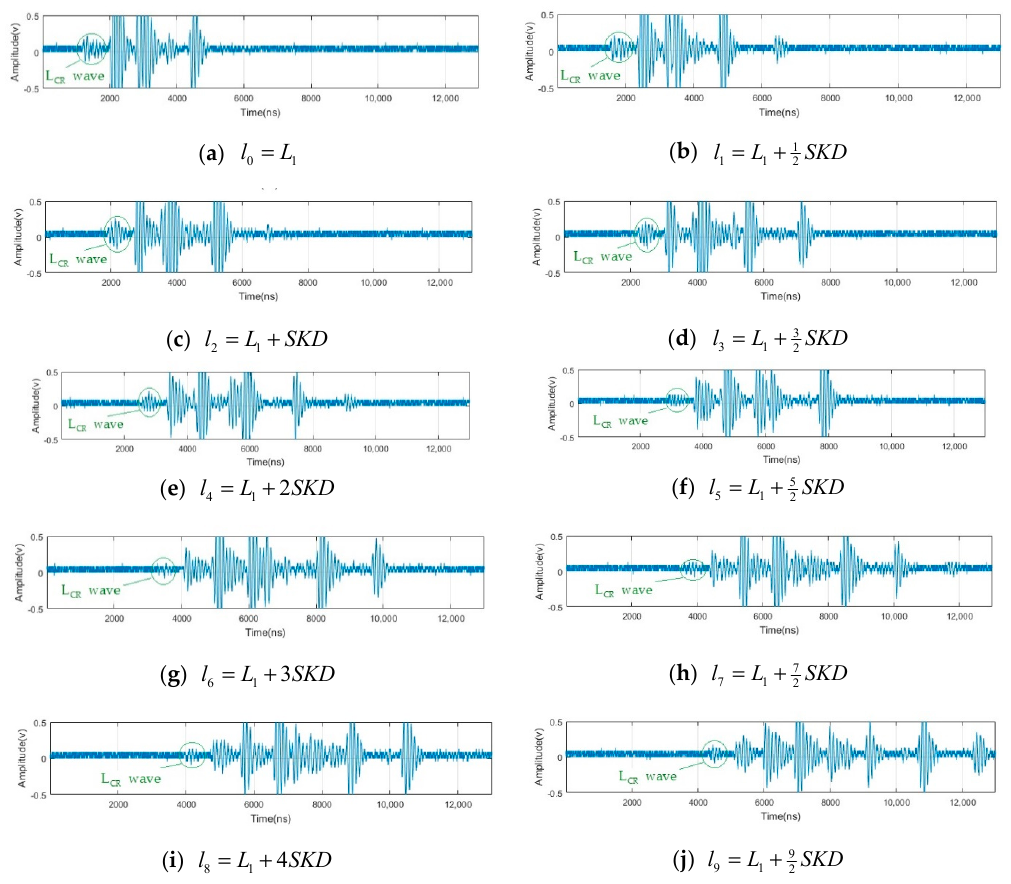
Figure 4. Received waves for different distances between the transmitter and the receiver (test conditions: frequency of transducers: 5 MHz, diameter of transducers: 6 mm. l : the distance